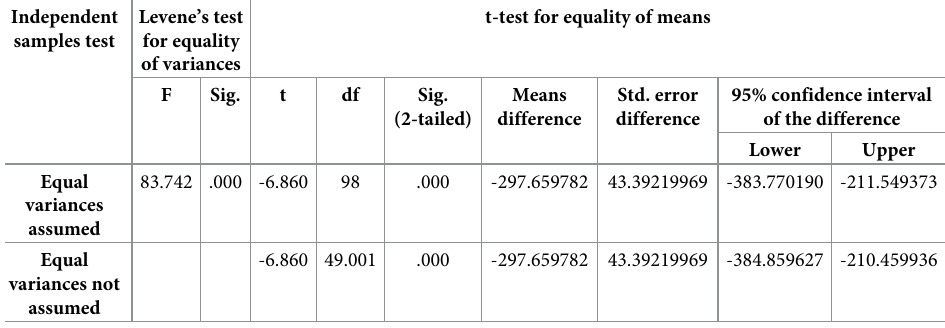
Table 11. Independent sample t-test for equality of means for the CSTHTS problem.